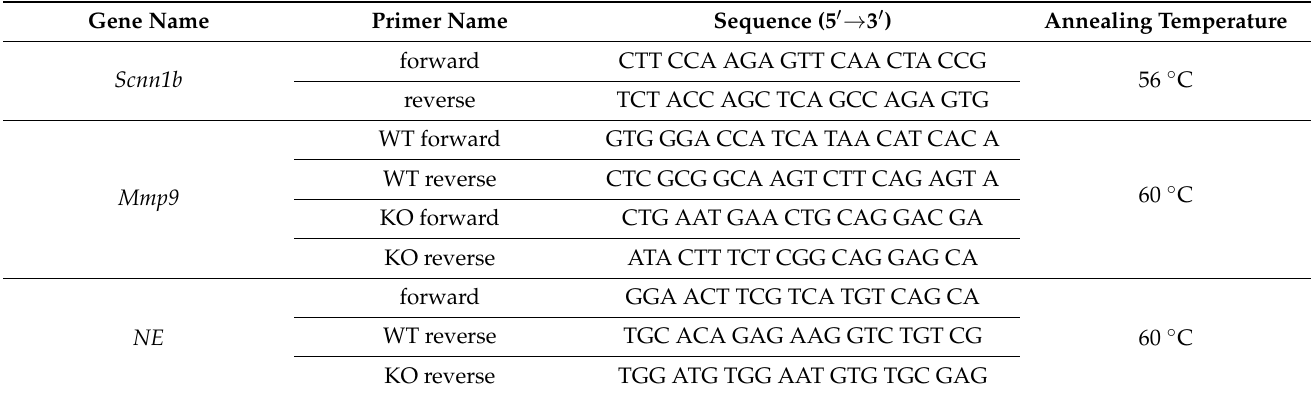
Table 1. Primer sequences used for